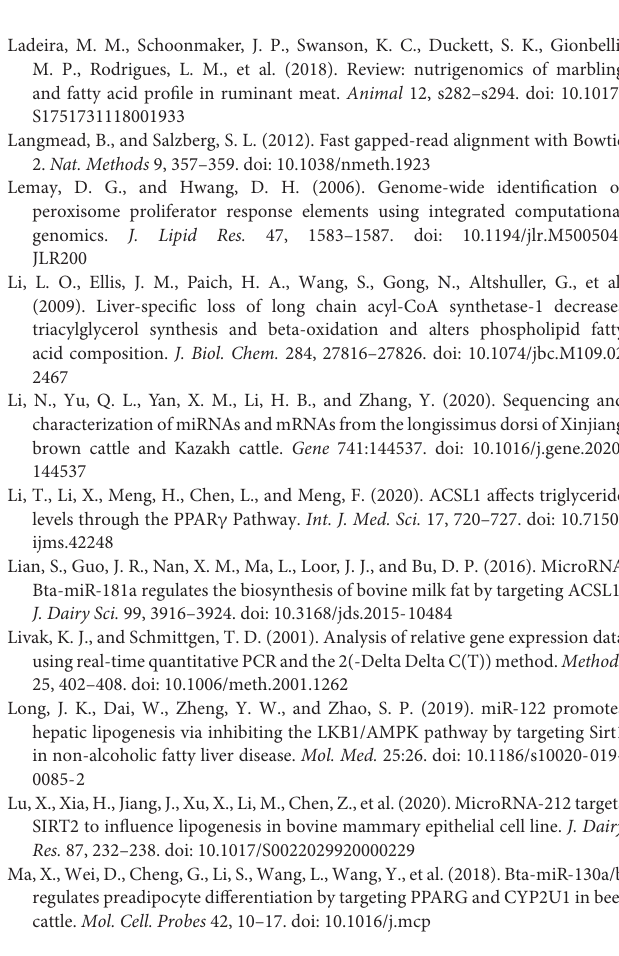
Supplementary Table 2 | Fatty acid classification. Supplementary Table 3 | Overview of the data for RNA sequencing. Supplementary Table 4 | Overview of the data for small RNA sequencing. Supplementary Table 5 | Differentially regulated mRNAs. Supplementary Table 6 | KEGG enrichment of DEGs. Supplementary Table 7 | Detected miRNA. Supplementary Table 8 | Differently expressed miRNAs. Supplementary Table 9 | The primer information of